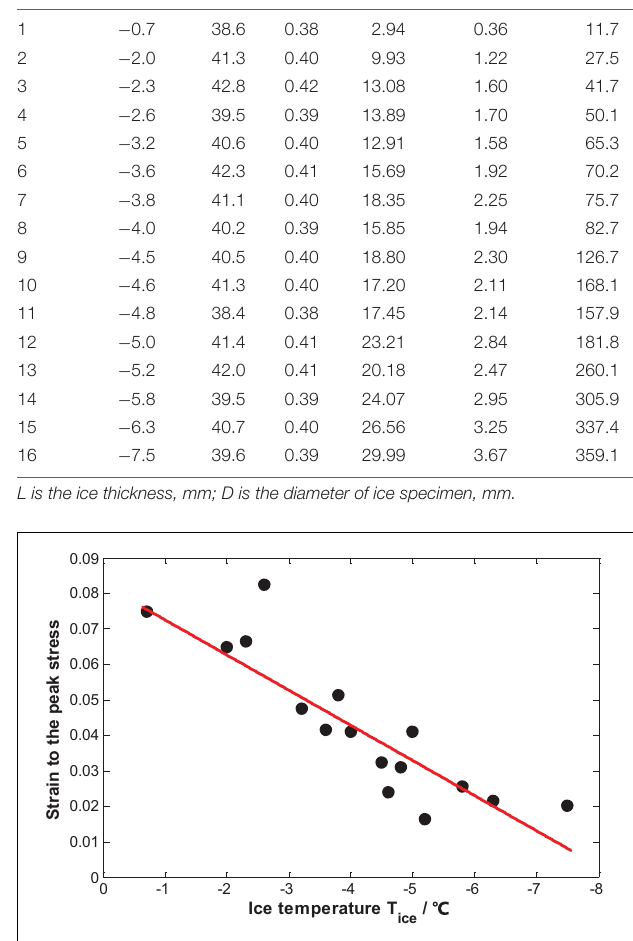
FIGURE 8 | Relationship between ice temperature and failure strain of ice.